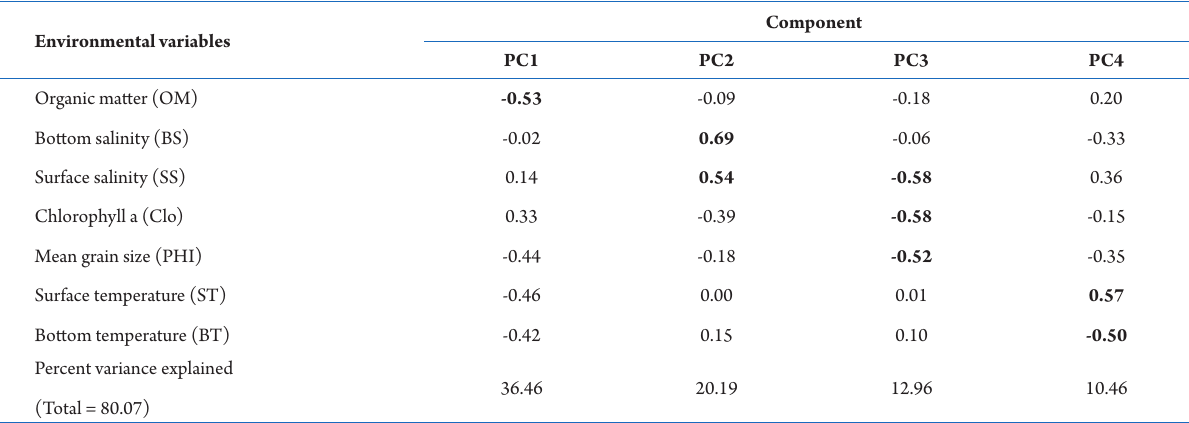
Table 2 . Summary statistics of the axes (PC) generated by the Principal Components Analysis for seven environmental variables measured during one year off Macaé, southeastern Brazilian coast. Coefficients ≥ ± 0.4 are considered ecologically important and are indicated in